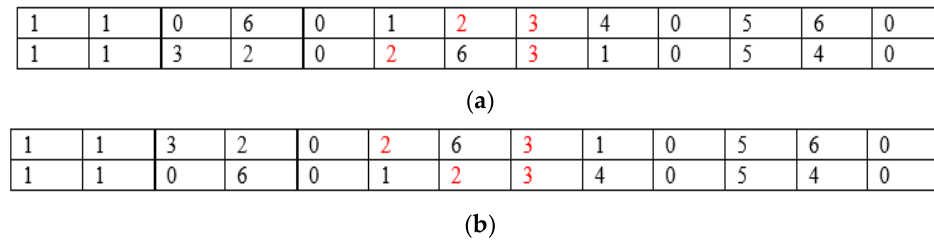
Figure 3. Crossover process: ( a ) chromosomes before crossover, ( b ) chromosomes after crossover.